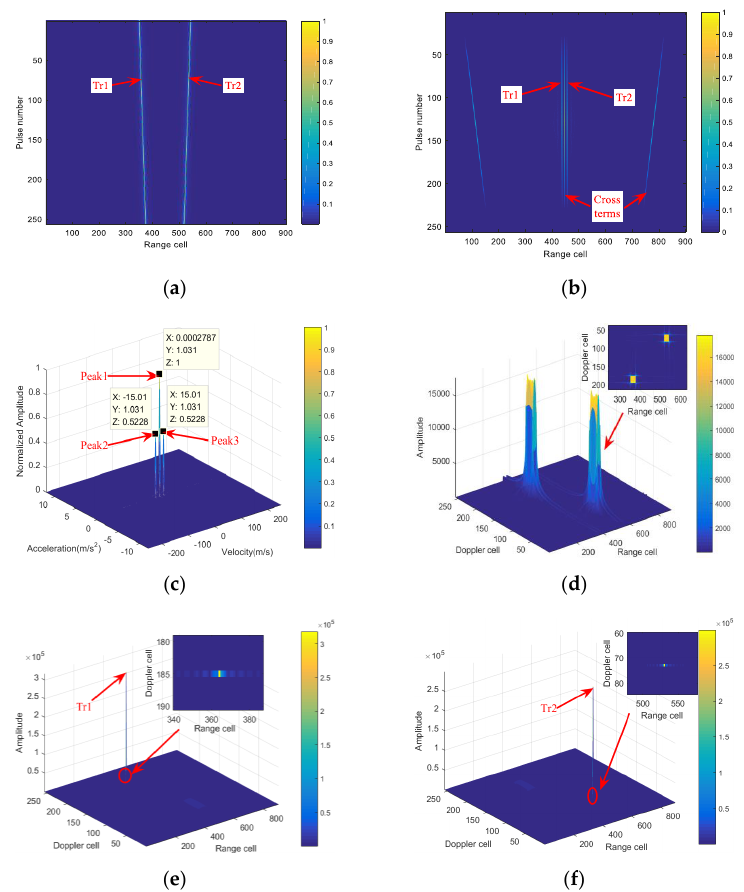
Figure 3. Simulation results of Example 3; ( a ) the result of pulse compression; ( b ) the result of the FD-SoPD; ( c ) the velocity-Acceleration distribution; ( d ) the coherent integration result with peak 1; ( e ) Coherent integration result with peak 2; ( f ) the coherent integration result with peak